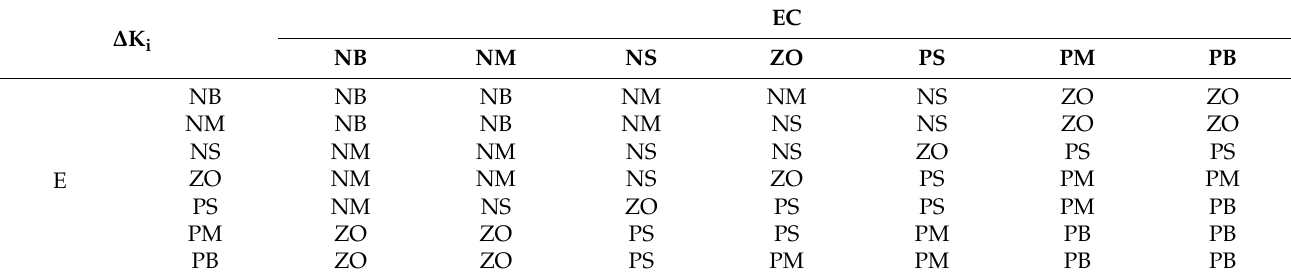
Table 3. Rule of Fuzzy-PID control of ∆ K i .